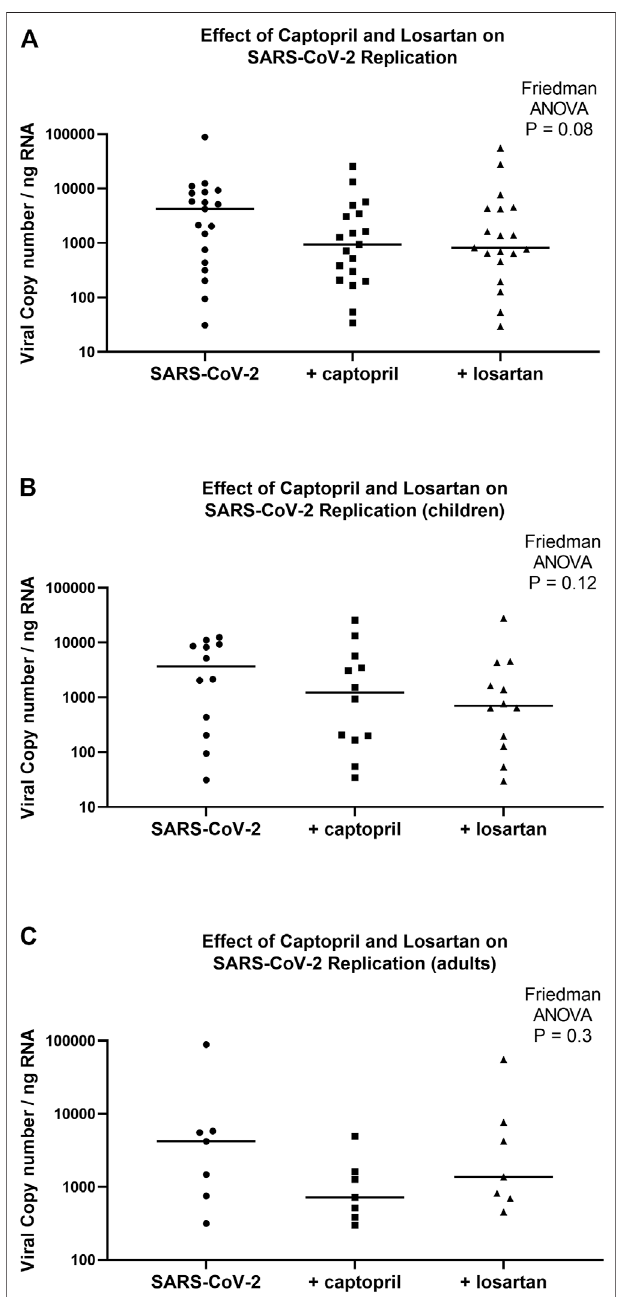
FIGURE 4 | SARS-CoV-2 replication in organotypic bronchial airway epithelial cell cultures from children ( n (cid:1) 12) and older adults ( n (cid:1) 7) 96 h followinginfectionofcultureswithamultiplicityofinfection(MOI)of0.5.SARS- CoV-2 copy number by quantitative PCR normalized to total RNA concentration. SARS-CoV-2 copy number was not signi fi cantly different between captopril treated, losartan treated, and untreated cultures (A) (children and adults combined, n (cid:1) 19; Friedman ANOVA p (cid:1) 0.08). (B) presents data from children separately ( n (cid:1) 12), wherein SARS-CoV-2 replication was not signi fi cantly different between captopril treated, losartan treated,anduntreatedcultures(FriedmanANOVA p (cid:1) 0.12). (C) presentsdata from adults separately ( n (cid:1) 7), wherein SARS-CoV-2 replication was not signi fi cantly different between captopril treated, losartan treated, and untreated cultures (Friedman ANOVA p (cid:1) 0.3).Median indicated by bold lines.